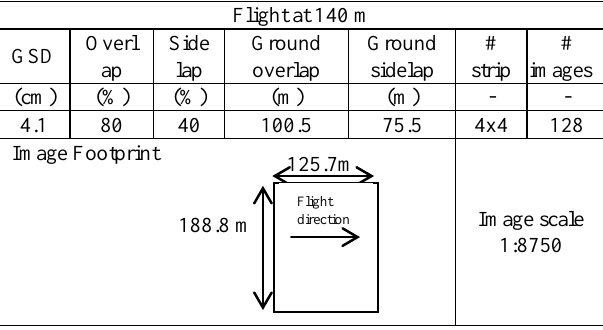
Table 2 – UAS flight plan characteristics at 140 m.